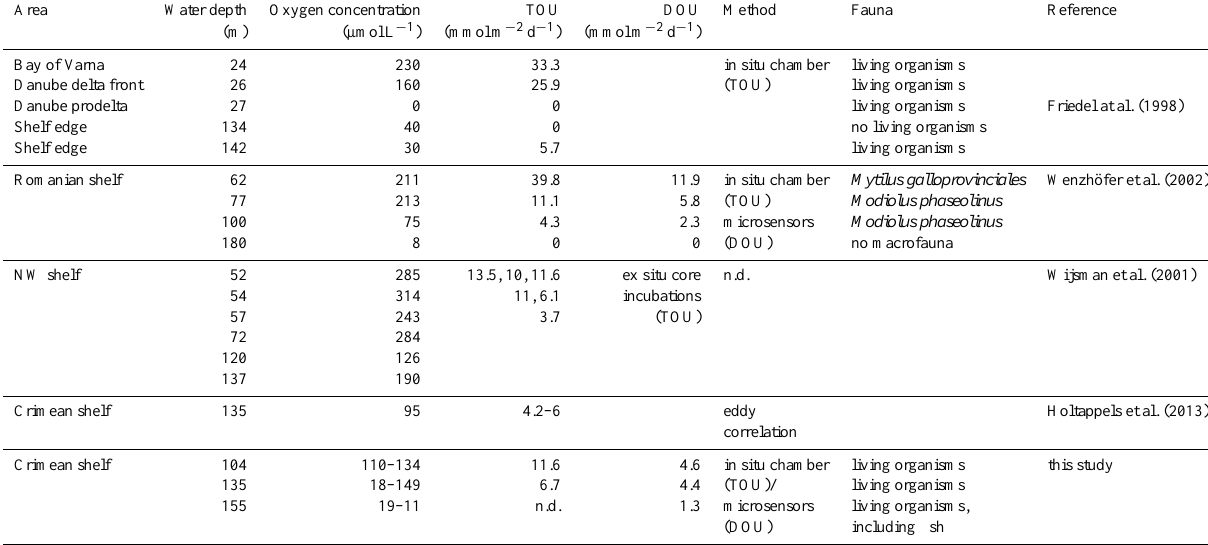
Table 4. Oxygen consumption in hypoxic areas of the Black Sea, n.d. depicts values not determined.